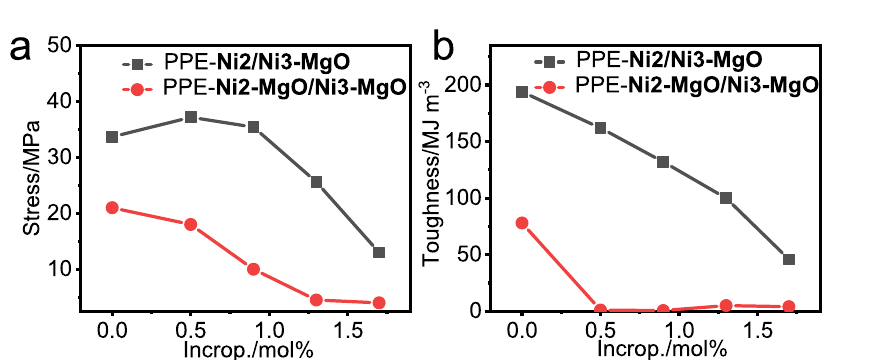
Fig. 5 | Correlation diagram of mechanical properties with polar monomer incorporation of a series of bimodal polyethylene samples. a Correlation dia- gramoftensilestrengthwithpolarmonomerincorporation. b Correlationdiagram